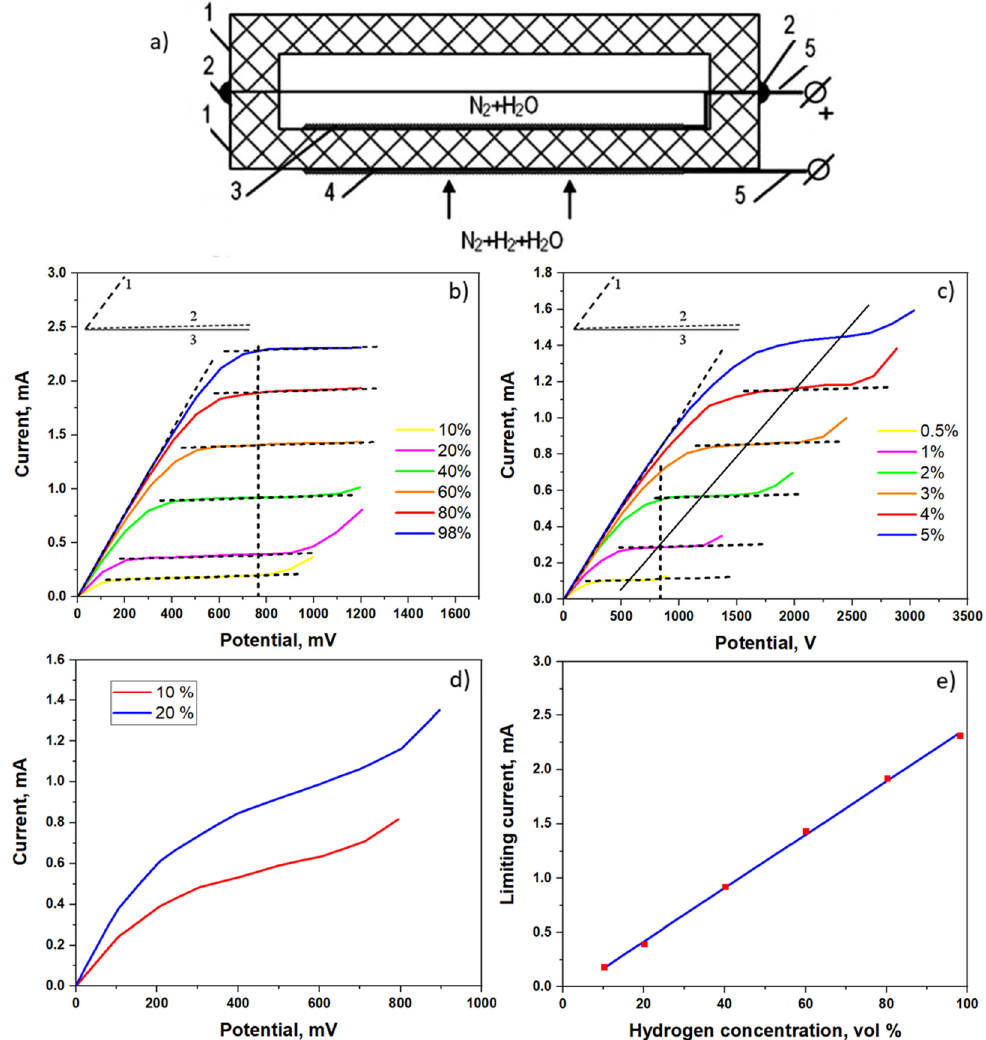
Figure 4. ( a ) Schematic illustration of the discussed amperometric hydrogen sensor: 1—solid elec- trolyte (proton conductor), 2—glass sealant, 3—internal Pt electrodes, 4—external Pt electrode, and 5—Pt leads; ( b ) the I-V curves for sensor 1 using La 0.95 Sr 0.05 YO 3 as solid electrolyte at different hy- drogen concentrations in the gas mixture of N 2 + 2%H 2 O + H 2 (800 °C); ( c ) I-V curves for sensor 2 using CaZr 0.9 Sc 0.1 O 3 as solid electrolyte at different hydrogen concentrations in the gas mixture of N 2 + 2%H 2 O + H 2 (800 °C); ( d ) I-V curves for sensor 3 using CaTi 0.95 Sc 0.05 O 3 as solid electrolyte at different hydrogen concentrations in the gas mixture of N 2 + 2%H 2 O + H 2 (800 °C); and ( e ) the limit- ing current of sensor 1 plotted against the hydrogen concentration. (Data reproduced with permis-